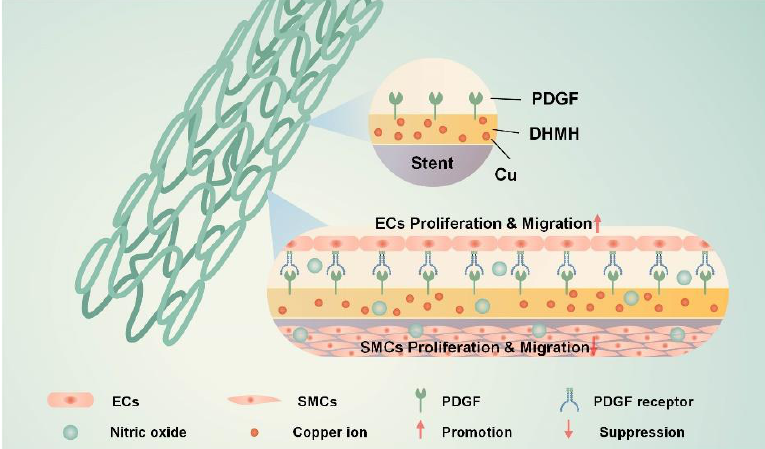
Figure 1. The schematic showing the surface modification strategy of the cardiovascular stent with the dual delivery of PDGF and NO.